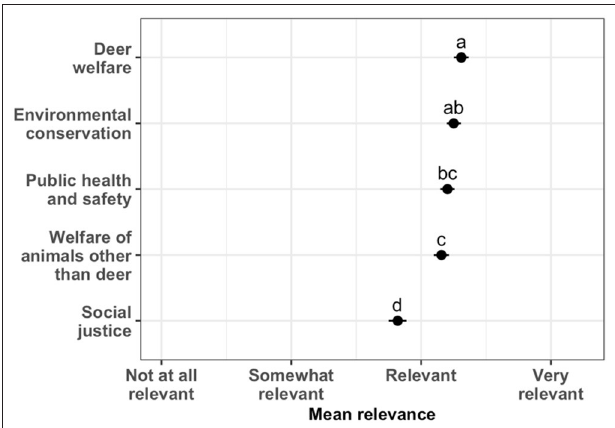
FIGURE 6 | Mean relevance of ethical considerations while responding to items on acceptability of shooting more deer, importance of people who shoot deer having certain characteristics, and acceptability of using meat and other deer parts in various ways. Points represent mean values after transforming responses from categories displayed on the x-axis into numerical values ranging from 0 (not at all relevant) to 3 (very relevant) and removing “I don’t know” responses. Error bars represent two standard errors of the mean. Considerations that share letters are not significantly different after Bonferroni correction (i.e., p <